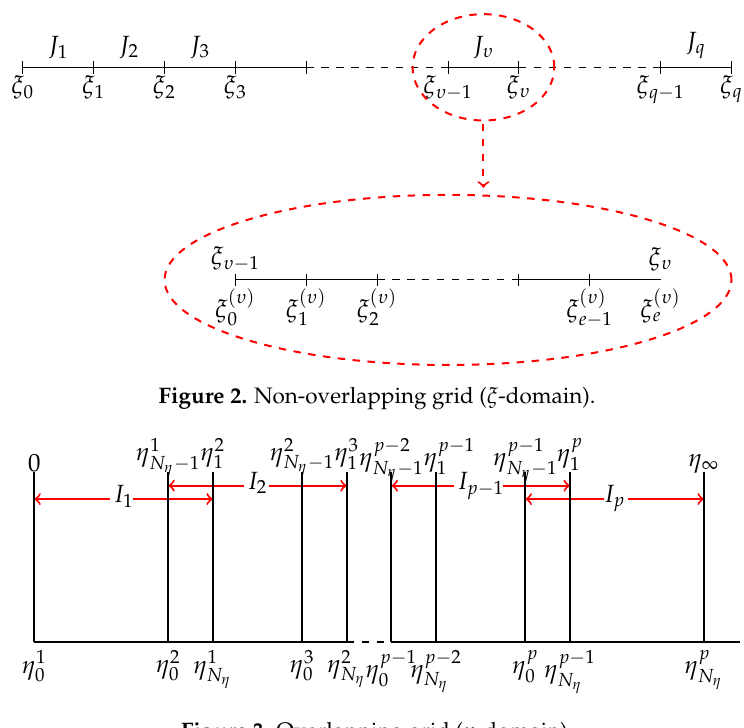
Figure 3. Overlapping grid ( η